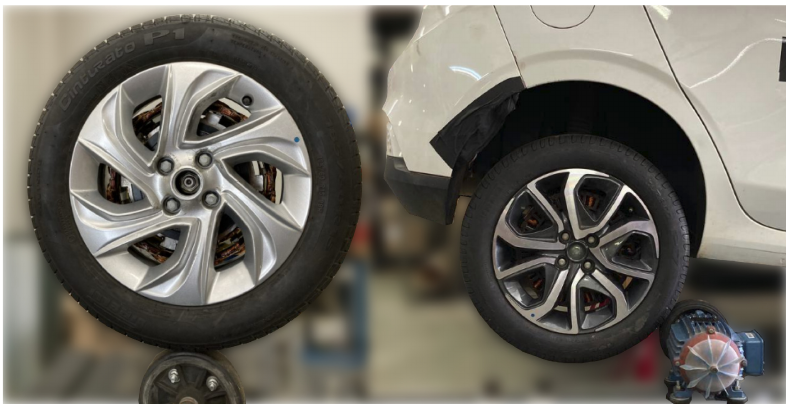
Figure 7. Machine test bench ( left ) and vehicle evaluation ( right